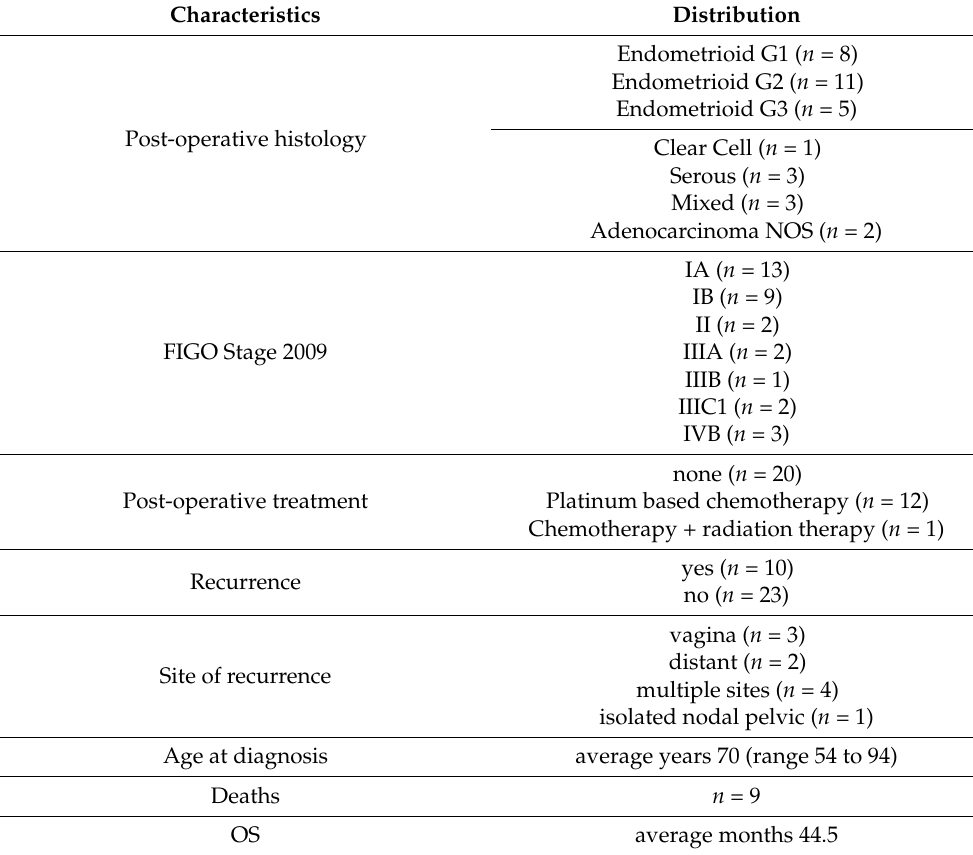
Table 1. Clinicopathological characteristics of the material ( n =